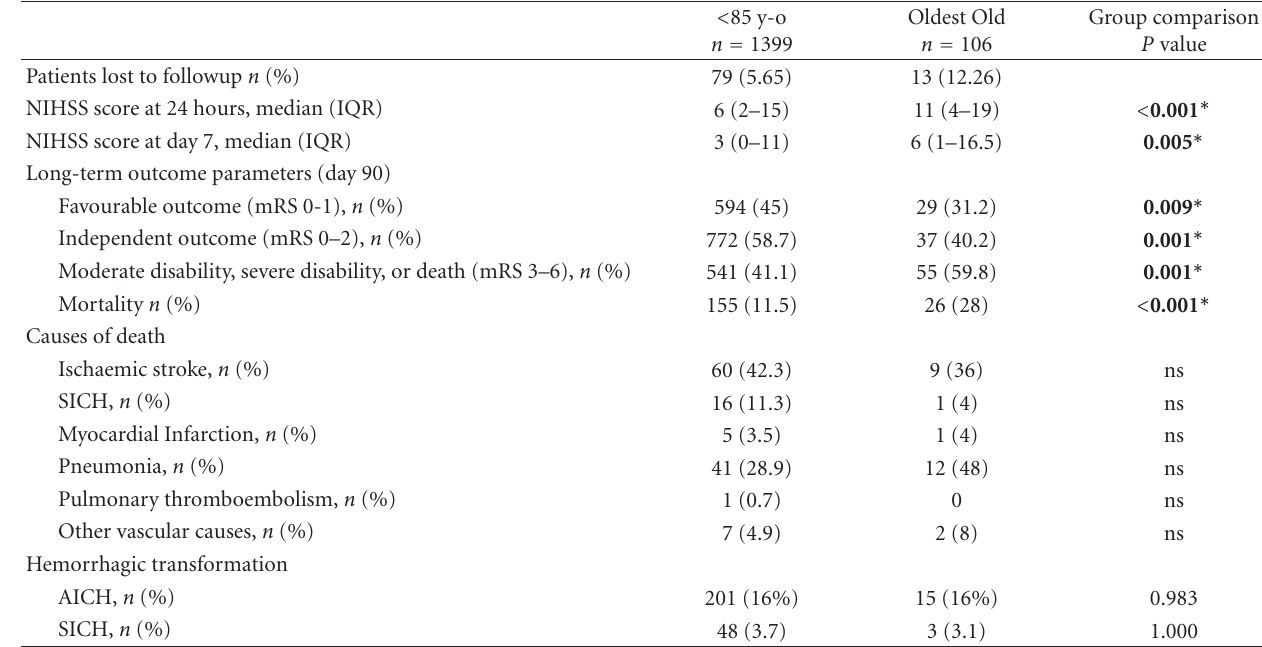
Table 2: Clinical outcome and haemorrhagic complications.